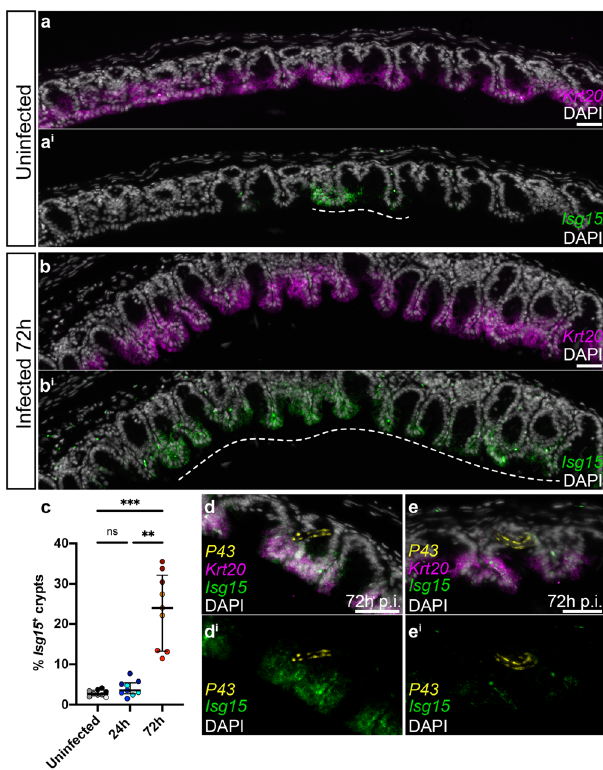
Fig. 9 Expansion of crypts with enterocytes expressing Isg15 upon whipworm infection. Representative images of expression of Isg15 (green) and Krt20 (magenta), visualised by mRNA ISH by HCR, in the caecum of a uninfected mice and b T. muris -infected mice after 72 h of infection. Dashed white lines show the extent of “ islands ” of Isg15 + crypts. c The number of Isg15 + crypts in a caecal section was calculated as a percentage of the total number of crypts across three sections from the same mouse, and with three mice analysed per condition (uninfected, 24 and 72 h p.i.). Data are presented as median values with interquartile range. among groups. For each condition, dots representing technical replicates are coloured identically. Source data are provided as a Source data fi le. d In some instances, worms were located near islands of Isg15 +